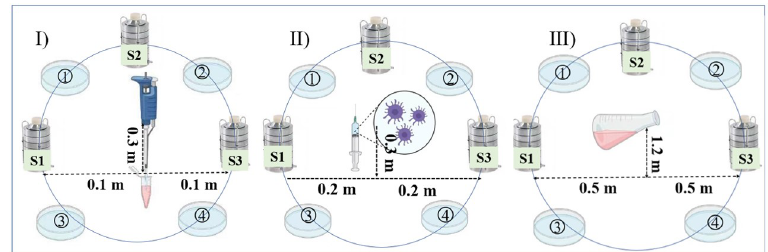
Figure 1. Sampling point location.